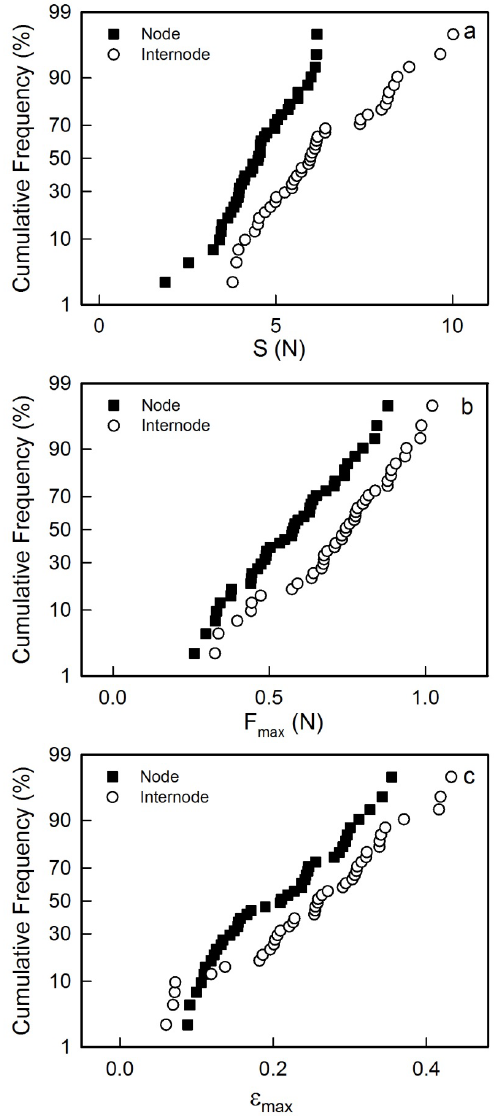
Fig. 5: Normal probability plot of the cumulative frequency distribution of stiffness (S) (a), maximum force (F max ) (b) and maximum strain ( ε max ) (c) of internodes and nodes of Chara coralline . Pooled data for positions 2 and 3.